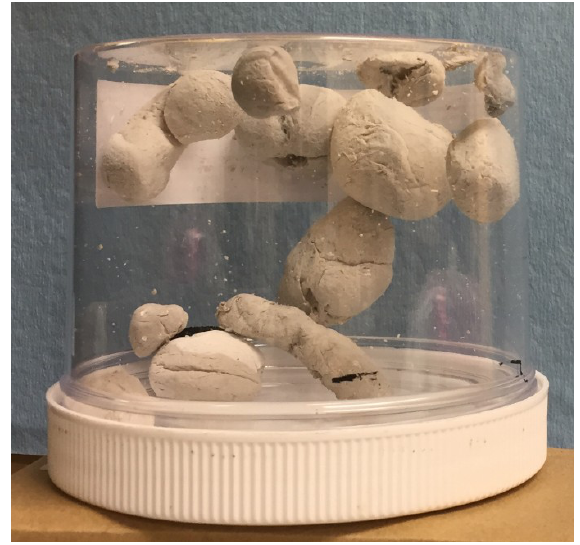
Figure 2. Photograph of 500-mg sample of bulk boron nitride nanotube (BNNT) material from BNNT, LLC, supplier.